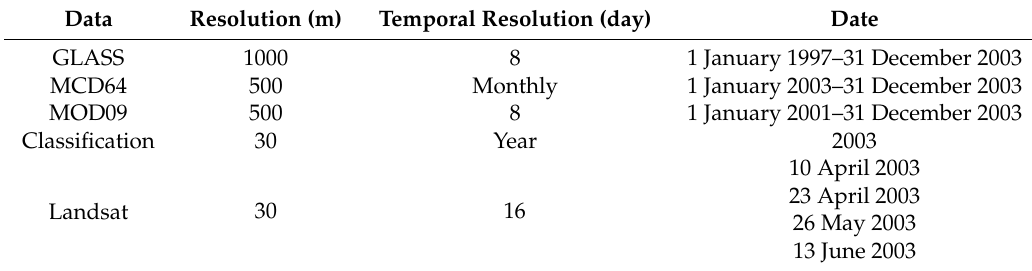
Table 1. Remote sensing data parameter list. GLASS = Global LAnd Surface